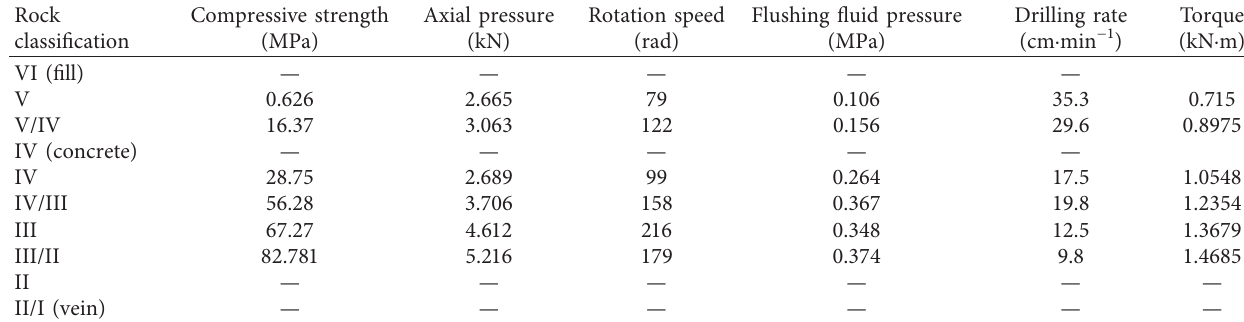
Table 10: Drilling parameters of hole